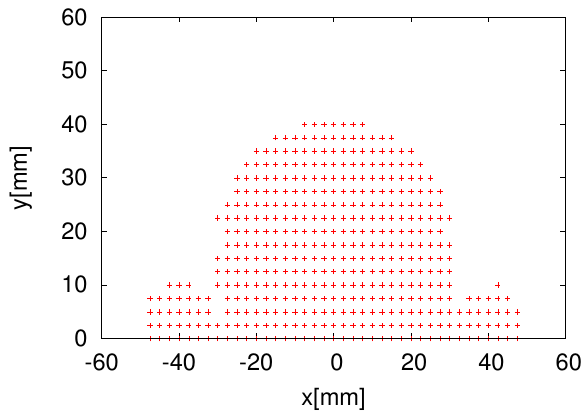
Figure 9. Detection area of the RFID reader antenna (data provided by Art Finex Co., Ltd., 6-1-33, Kamikoubata, Sabae, Fukui, Japan).